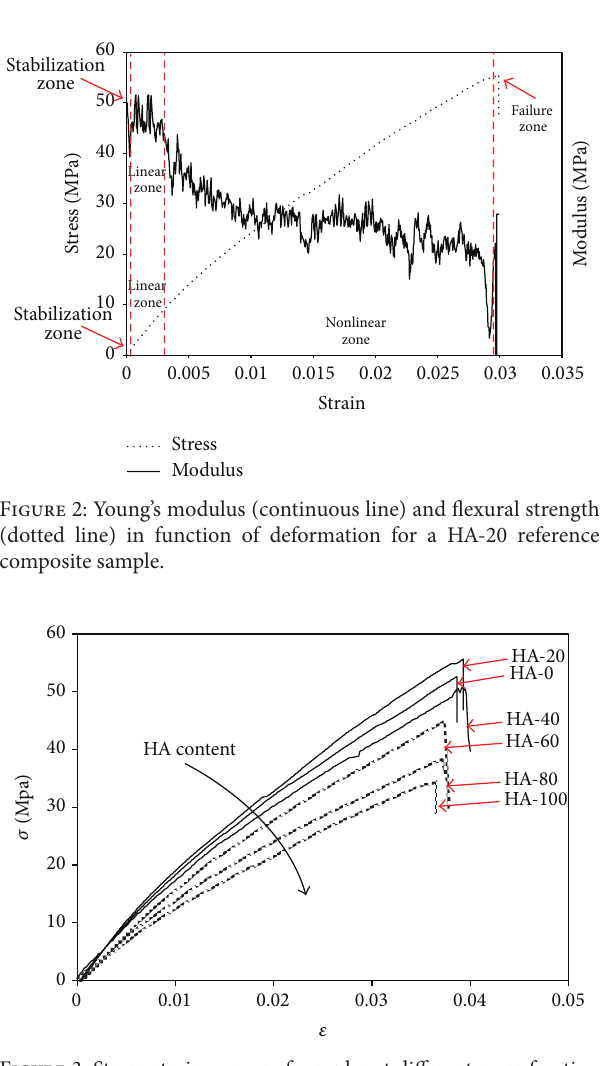
Figure 3: Stress-strain curves of samples at different mass fraction of hydroxyapatite whiskers filled resin composite.